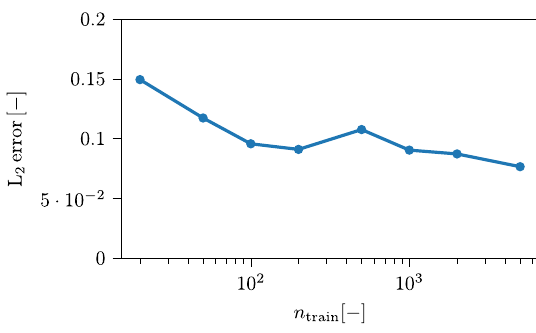
Fig. 12 Error for GP regression model with n test = 100 test points over number of training data points n